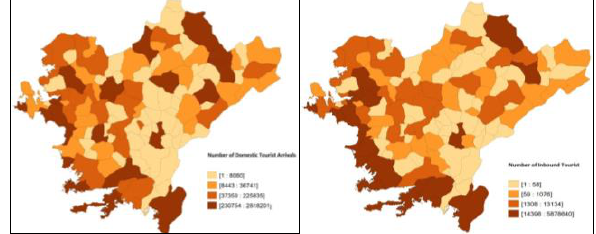
Figure 1. The choropleths maps of domestic and inbound tourist arrivals